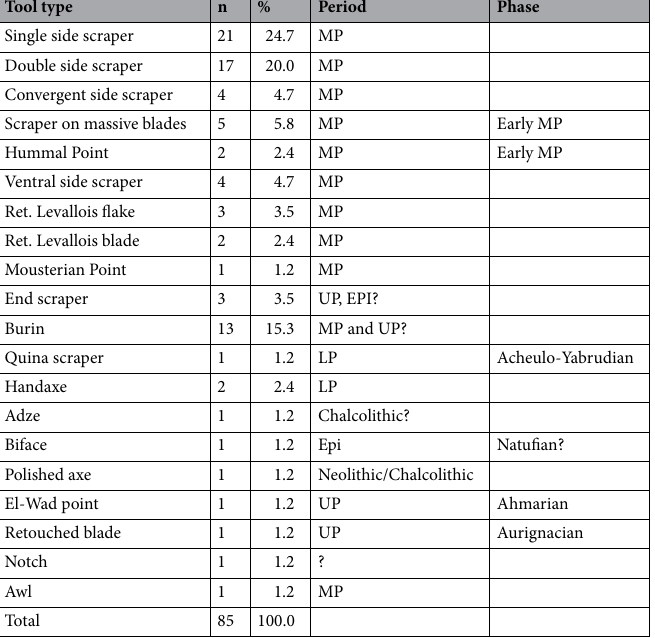
Table 2. Typology of retouched items in the Rockefeller Museum Shukbah Layer D sample.